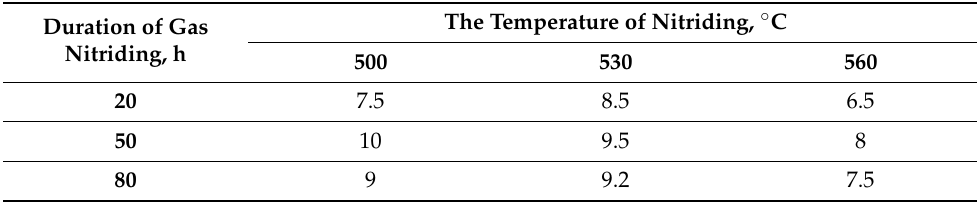
Table 2. Average values of the experimentally obtained data of the surface hardness of steel 38Cr2MoAl after gas nitriding,